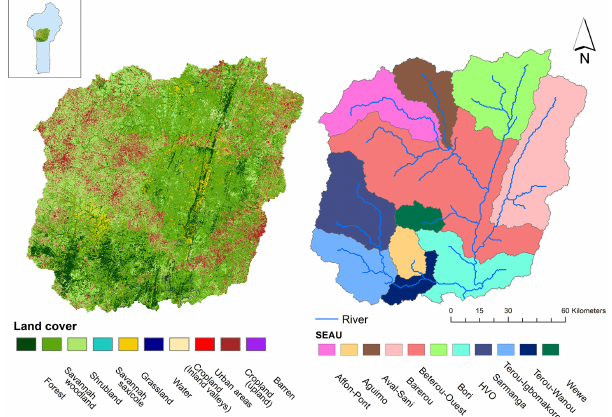
Figure 1. Land cover and subwatershed ecosystem accounting units (SEAUs) of the Upper Ouémé watershed. Land cover data adapted from Judex and Thamm